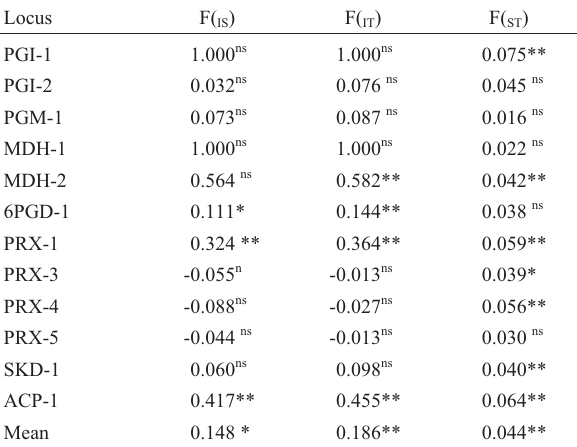
Table VI - Selected estimates of F IS , F IT and F ST estimates of contrasting individual or grouped populations of Araucaria angustifolia based on 15 loci.